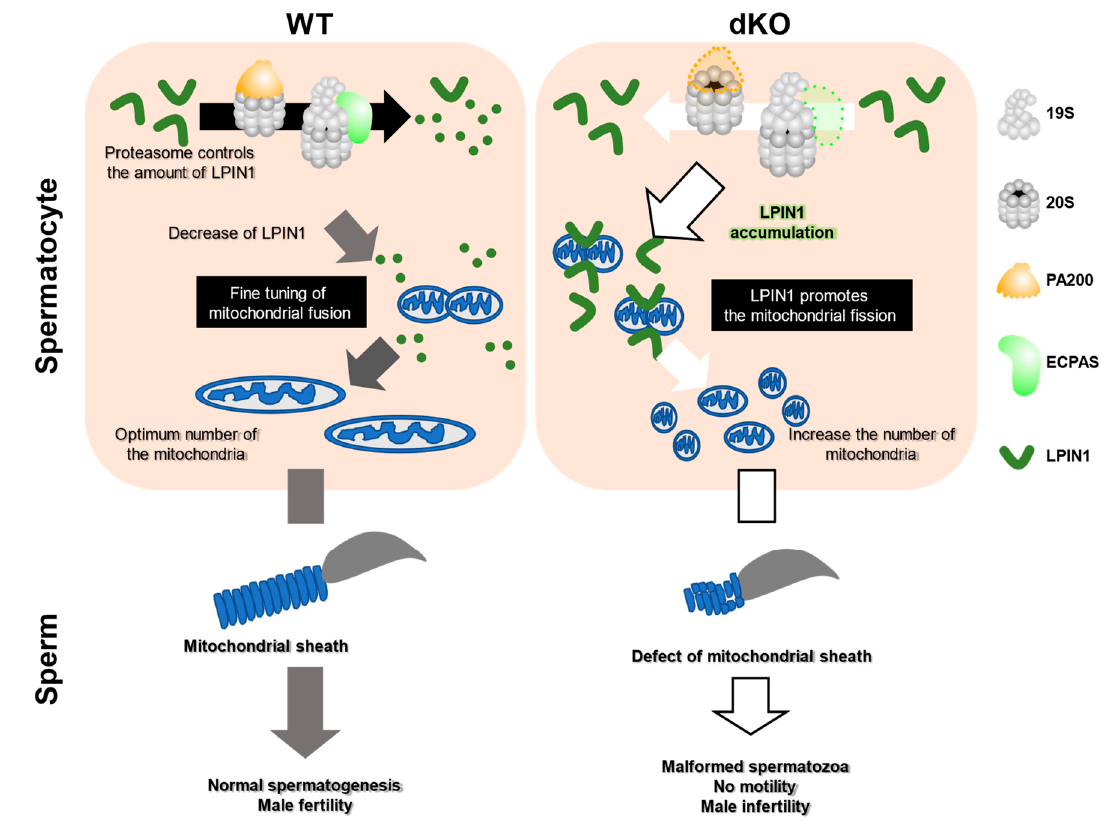
Figure 5. Schematic model of LPIN1 accumulation during spermatogenesis in dKO mouse. Among spermatogenesis, the proteasome controls the amount of LPIN1. At the mitochondrial fusion step, the proteasome may fine-tune the number of mitochondria via LPIN1 degradation which makes the number of mitochondria optimum. In contrast, dKO of PA200 and ECPAS (dashed lines) cause accumulation of LPIN1 in spermatocytes. Accumulated LPIN1 then promotes mitochondrial fission via the consumption of phosphatidic acid and increases the number of mitochondria in spermatocytes. Sperm in dKO showed a defective mitochondrial sheath and reduced motility.